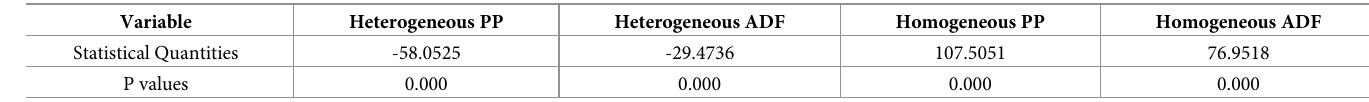
Table 5. Panel data cointegration test.